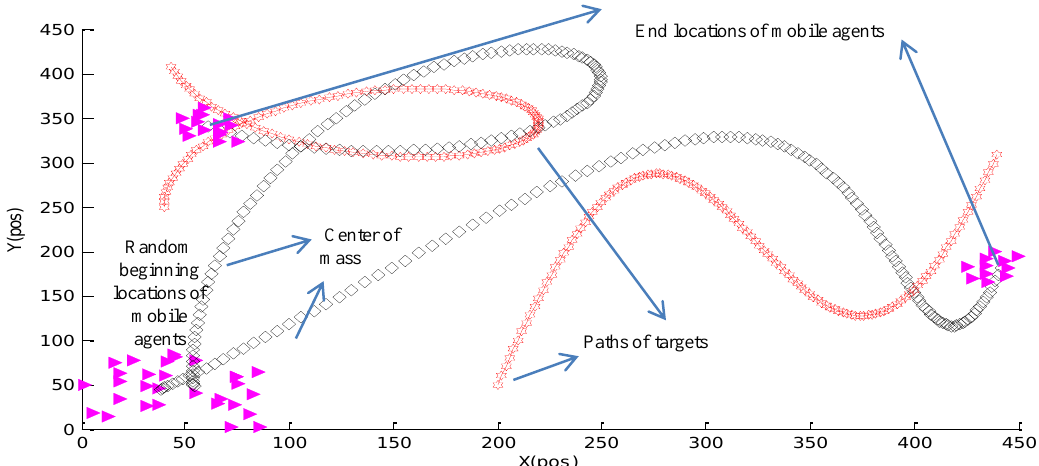
Figure 6. Beginning and ending locations of 50 mobile agents that are following two moving target in semi-circular and semi- sine wave paths with extended flocking control algorithm using (9)